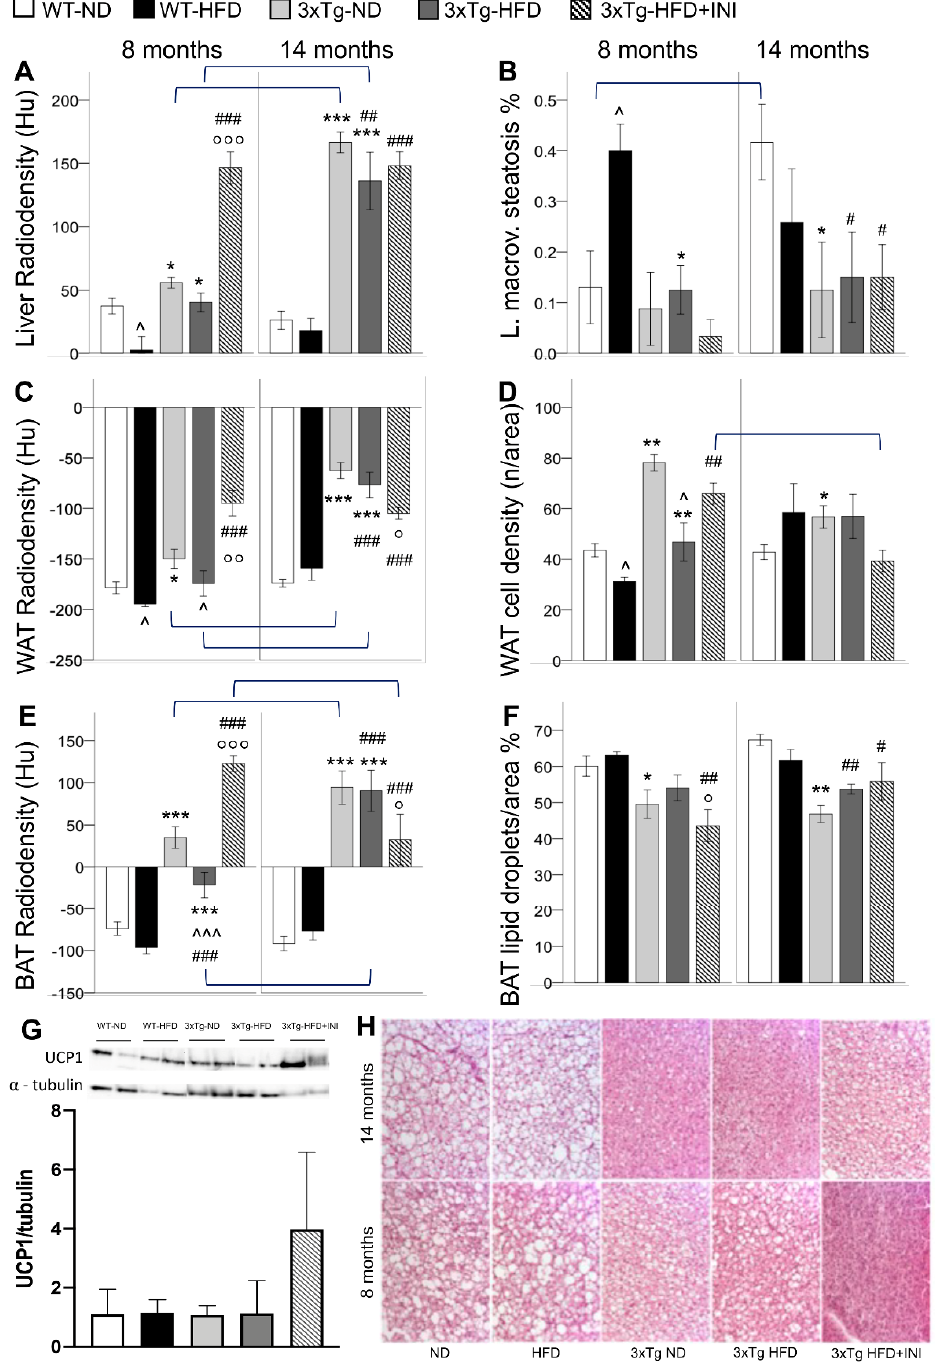
Figure 2. CT radiodensities of the liver, WAT, and BAT ( A , C , E ), and related histological features, i.e., liver macro-vesicular steatosis ( B ), WAT cell density ( D ), and BAT lipid droplets % ( F ) in WT and 3xTg mice, fed ND or HFD, at age 8 and 14 months. Bar graph shows the mean of two Western blot experiments for BAT UCP1 protein expression in 8 months old mice ( G ), and representative BAT histological sections H&E stained demonstrating the severe lipid depletion (white areas corresponding to lipid droplets) observed in 3xTg mice ( H ). Mean ± SEM shown. Different symbols are used for each within-age comparison, * p ≤ 0.05 vs. WT, ** p ≤ 0.01 vs. WT, *** p ≤ 0.001 vs. WT, ˆ p ≤ 0.05 vs. ND, ˆˆˆ p ≤ 0.001 vs. ND, # p ≤ 0.05 vs. WT-ND, ## p ≤ 0.01 vs. WT-ND, ### p ≤ 0.001 vs. WT-ND, ◦ p ≤ 0.05 vs. 3xTg-HFD, ◦◦ p ≤ 0.01 vs. 3xTg-HFD, ◦◦◦ p ≤ 0.001 vs. 3xTg-HFD. A line is used to identify statistically significant differences in between-age